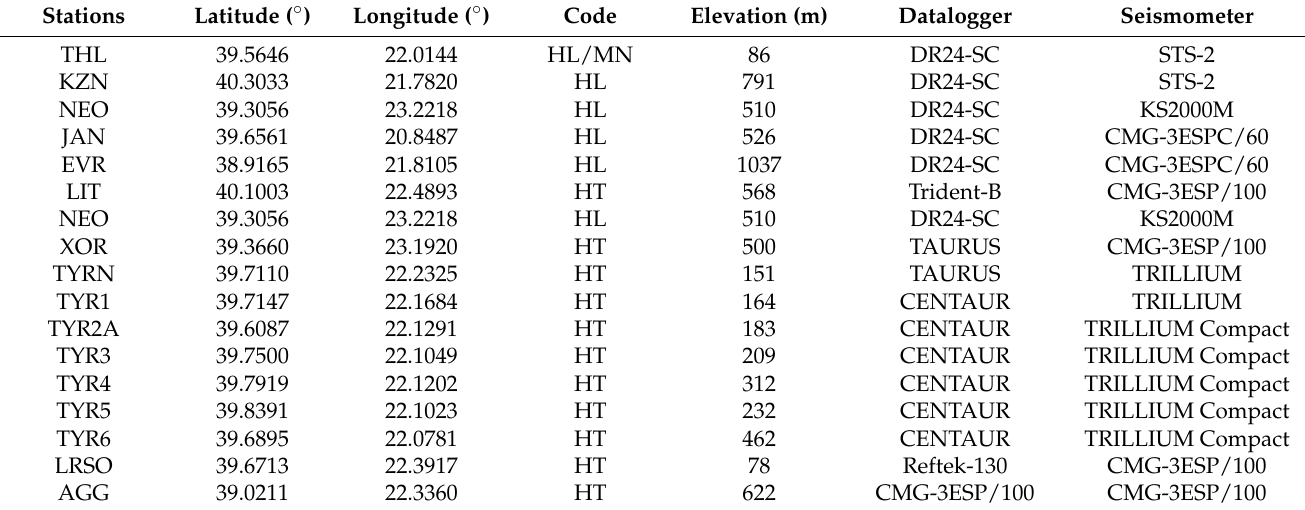
Table 1. Characteristics of the seismological stations in the broader area of Greece, the data from which were used in this study. Station coordinates are in decimal degrees; the elevation is in m. HL denotes the seismological network of the National Observatory of Athens; HT represents the seismological network of the University of Thessaloniki; MN designates the stations that belong to the MedNet (Mediter- ranean Seismological Network). Sources: Available online: https://bbnet.gein.noa.gr/HL (accessed